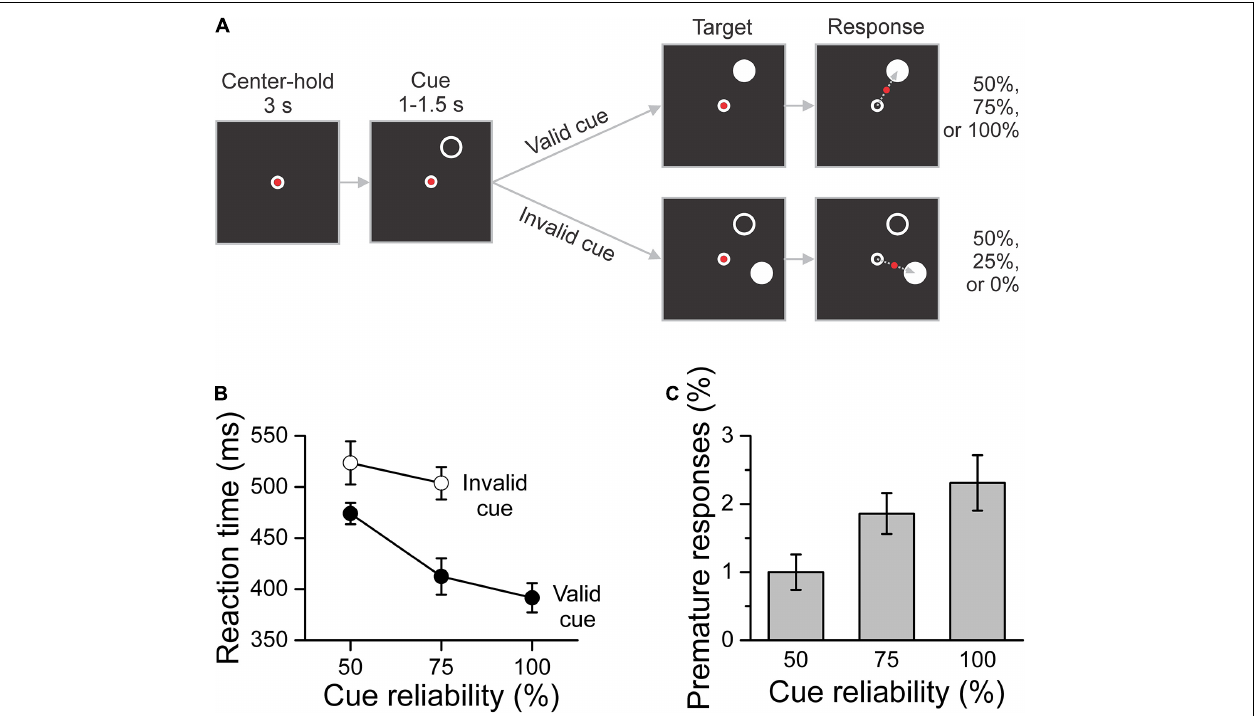
FIGURE 1 | Task and behavioral results. (A) Schematic description of the task. After a 3 s center-hold period, a peripheral cue (white circle) was presented for 1–1.5 s in any direction around the center. The direction of the cue was selected randomly in the 0–360 deg range from trial to trial. The cue indicated the location of the upcoming target (white disc) with 50, 75, or 100% reliability depending on the block of trials. Participants were informed of the cue reliability condition before the start of the block of trials. After target onset, which determined whether the trial had a valid or invalid cue, participants responded by moving a joystick-controlled cursor (red dot) from the center of the screen to the target as quickly and accurately as possible. (B) Mean reaction time across participants per cue reliability and cue validity conditions. Mean reaction time decreased significantly as cue reliability increased and was significantly shorter for valid-cue trials than for invalid-cue trials. (C) Percent of premature responses per cue reliability condition averaged across participants. The percent of premature responses increased significantly with cue reliability. The error bars indicate the SEM ( N = 12 participants) for within-subject designs (Cousineau, 2005; Morey,